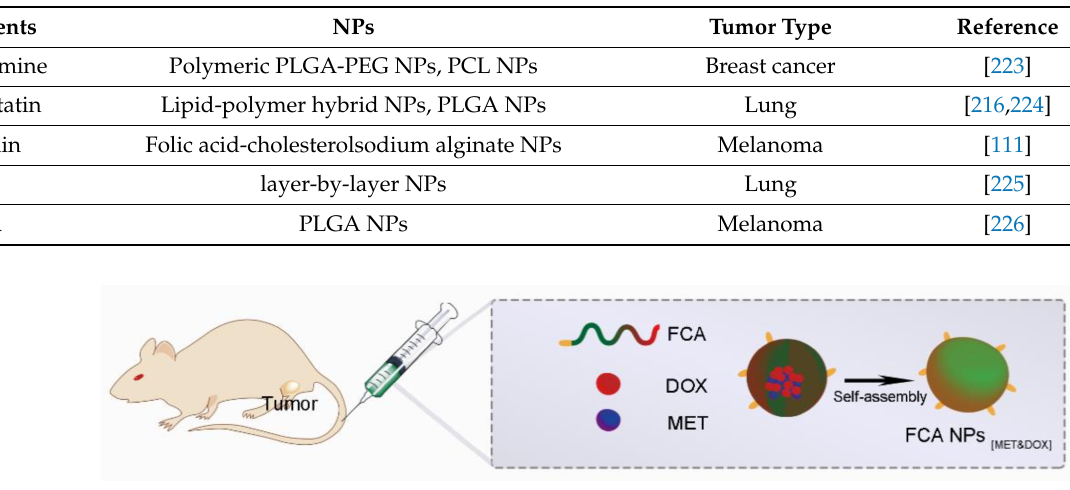
Figure 2. The self-assembled polymeric nanocarrier-mediated co-delivery of metformin and doxoru- bicin for melanoma therapy Reproduced from Song et al.